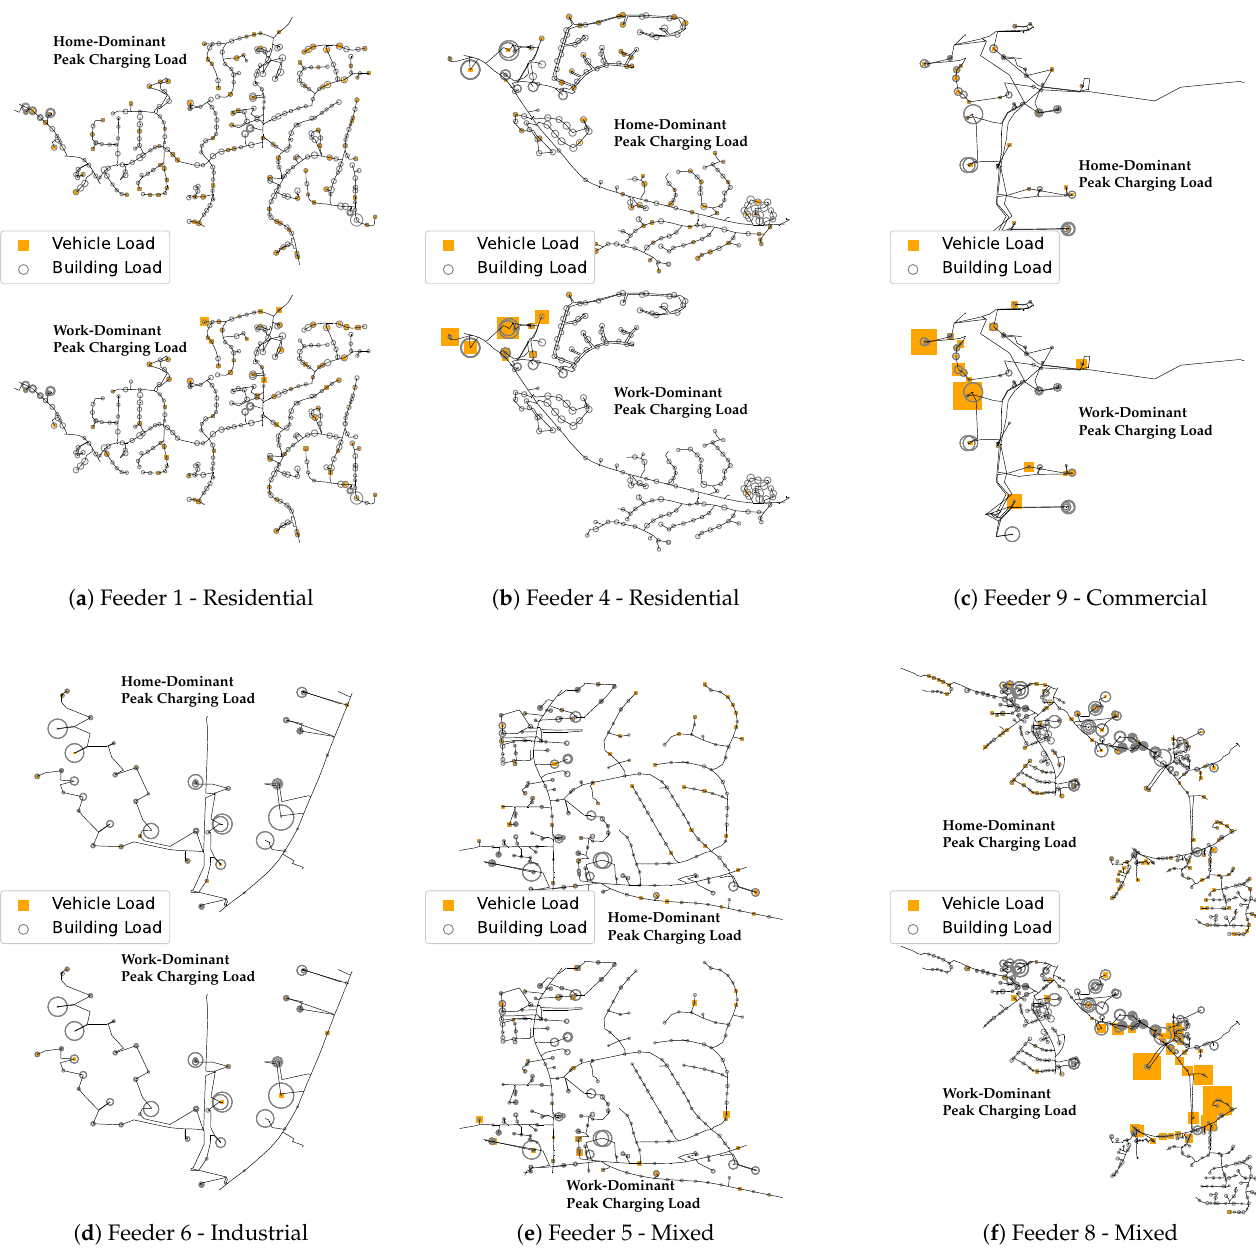
Figure 7. The feeder maps depict the Electric Vehicle (EV) charging locations at the home- and work-dominant peaks for the respective feeders. Notable findings include the following: the two residential feeders, Feeders 1 ( a ) and 4 ( b ), experienced different EV charging behaviors; the commercial feeder ( c ) had a significant increase in the amount of charging at commercial loads; ( d ) Industrial Feeder 6; the mixed use feeders also had varied spatial results where Feeder 8 ( f ) had a significant number of EV charging at one location and Feeder 5 ( e ) did not have as significant of a change between the two